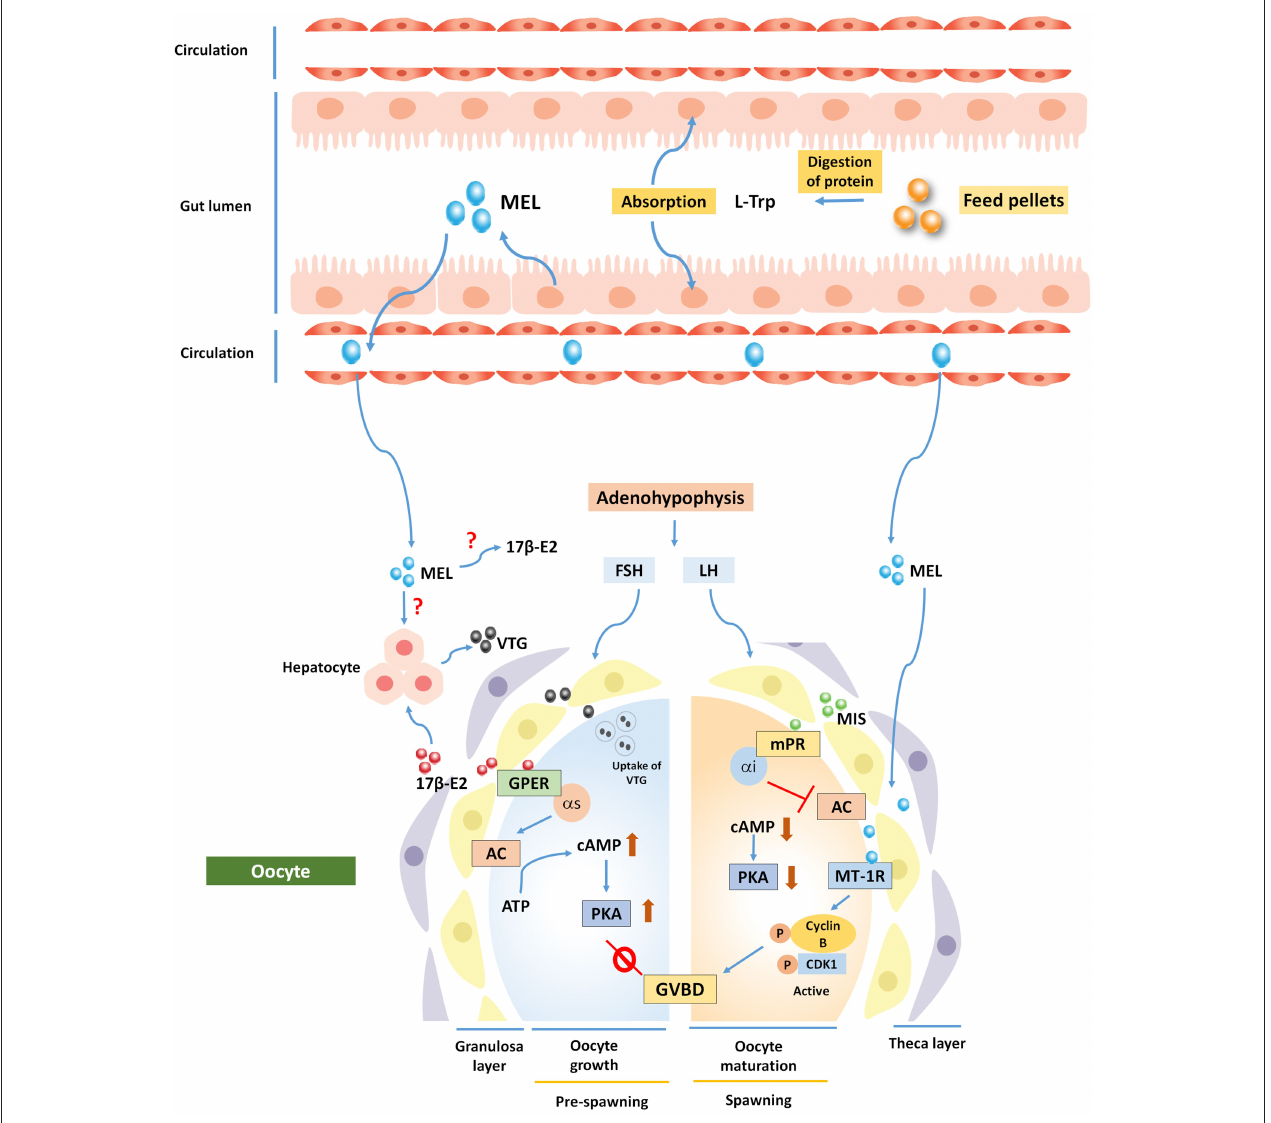
FIGURE 3 | Potential involvement of MEL in the regulation of fish oogenesis. Ovarian follicles synthesize 17 β -E 2, which acts via membrane bound G-protein-coupled estrogen receptor 1 (GPER) and increases intra-oocyte cAMP level to inhibit oocyte maturation. A shift in steroidogenesis is governed by maturation-inducing steroid (MIS), which acts on oocyte via Membrane progestin receptor (mPR) to regulate germinal vesicle breakdown (GVBD). MEL is thought to exert its action through melatonin receptor 1 (MT1R) to regulate oocyte maturation. MEL has also a negative role in synthesizing vitellogenin (VTG) protein from carp hepatocyte, but direct actions on 17 β -E 2 and VTG are still